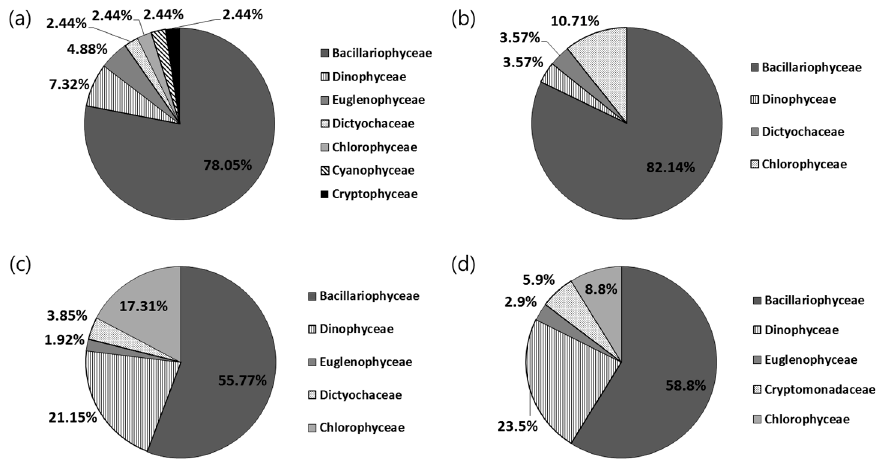
Figure 7. Seasonal phytoplankton composition in the Taehwa River estuary in Korea. ( a ) February, ( b ) May, ( c ) August, and ( d ) November.